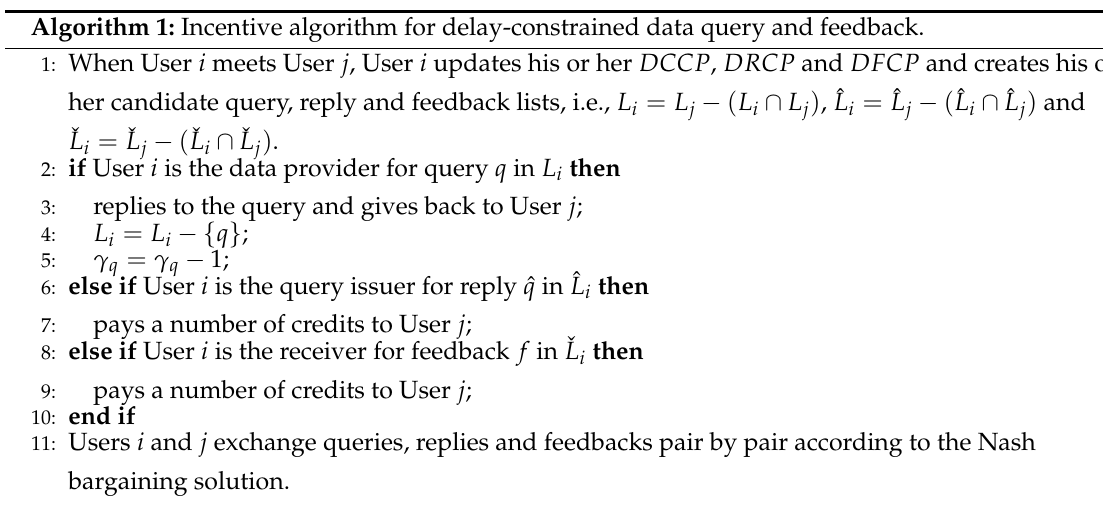
Algorithm 1: Incentive algorithm for delay-constrained data query and